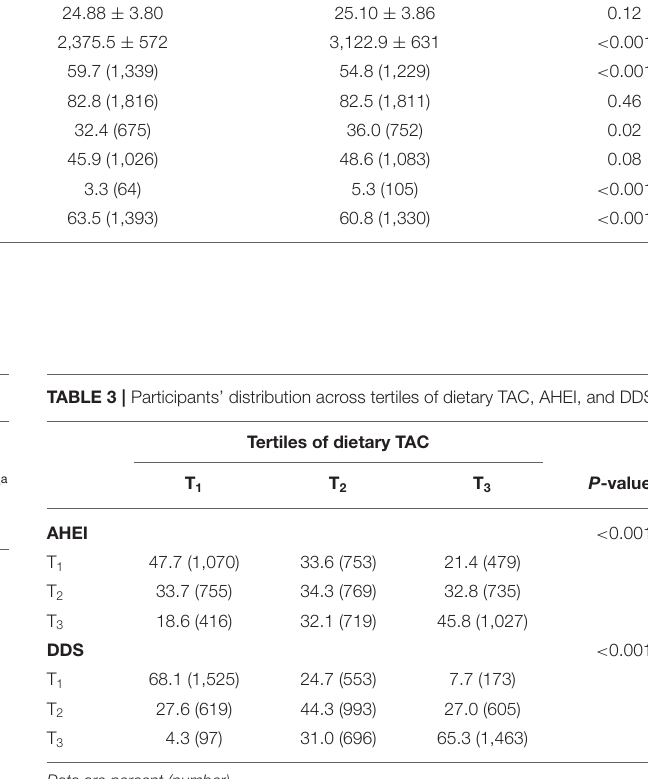
Tertiles of dietary TAC